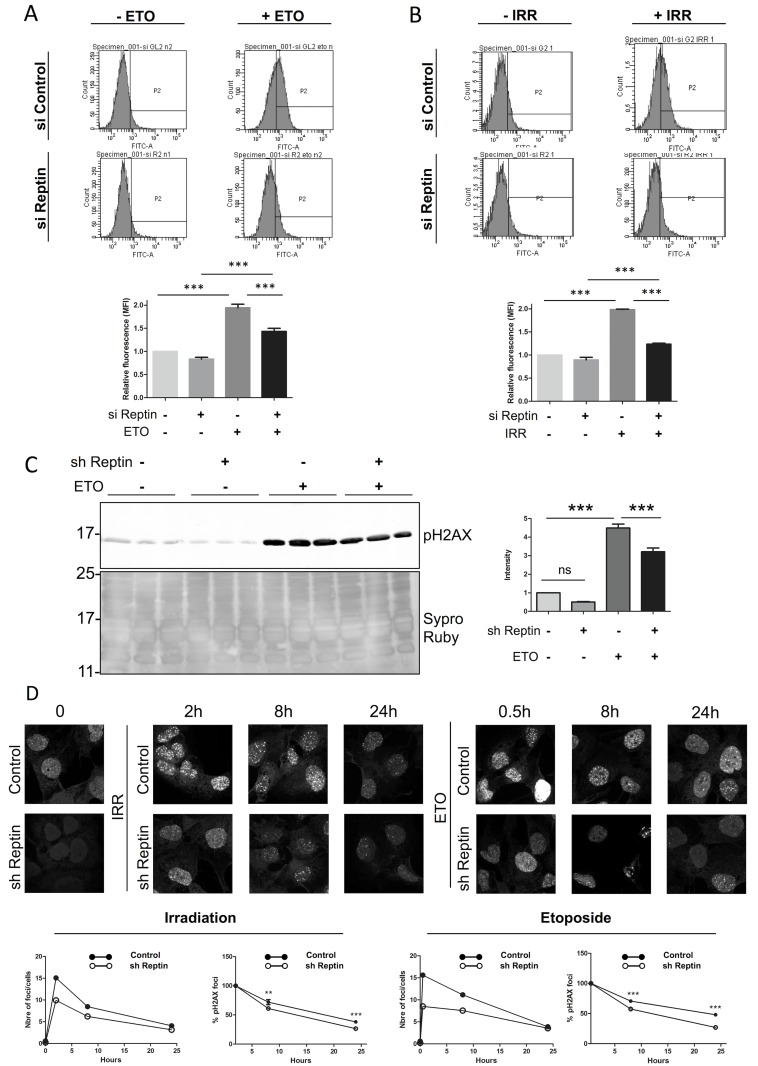
Reptin depletion impairs H2AX phosphorylation at serine 139 (γH2AX) after DNA damage.(A) and (B) HuH7 cells were transfected with a control or a Reptin siRNA. After 3 days, they were then treated with etoposide (ETO, 25 μM) (A) or exposed to gamma radiation (IRR, 4 Gy) (B), stained for γ-H2AX and analyzed by flow cytometry. The bar graphs show the mean of 3 experiments (*** p<0.001 by One-way ANOVA followed by Bonferroni test). (C) and (D) HuH7 cells stably expressing a doxycycline-inducible Reptin shRNA were treated with doxycycline (sh Reptin +) or left untreated (sh Reptin-) for 4 days. Extracts from HuH7 cells treated with etoposide as in (A) were analyzed by Western blot with an anti-phospho-H2AX antibody (C). Data were normalized relative to the Sypro Ruby staining of the membrane. The graph on the right shows the mean of 9 experiments (*** p<0.001 by One-way ANOVA followed by Bonferroni test). (D) Control or Reptin depleted HuH7 cells were treated with etoposide or irradiated, then fixed at different time points and immunostained for phospho-H2AX. The graphs below show for each treatment the evolution of the number of foci per cell (left) or the fractional decrease of the number of foci, setting the initial time point as 100% (right).